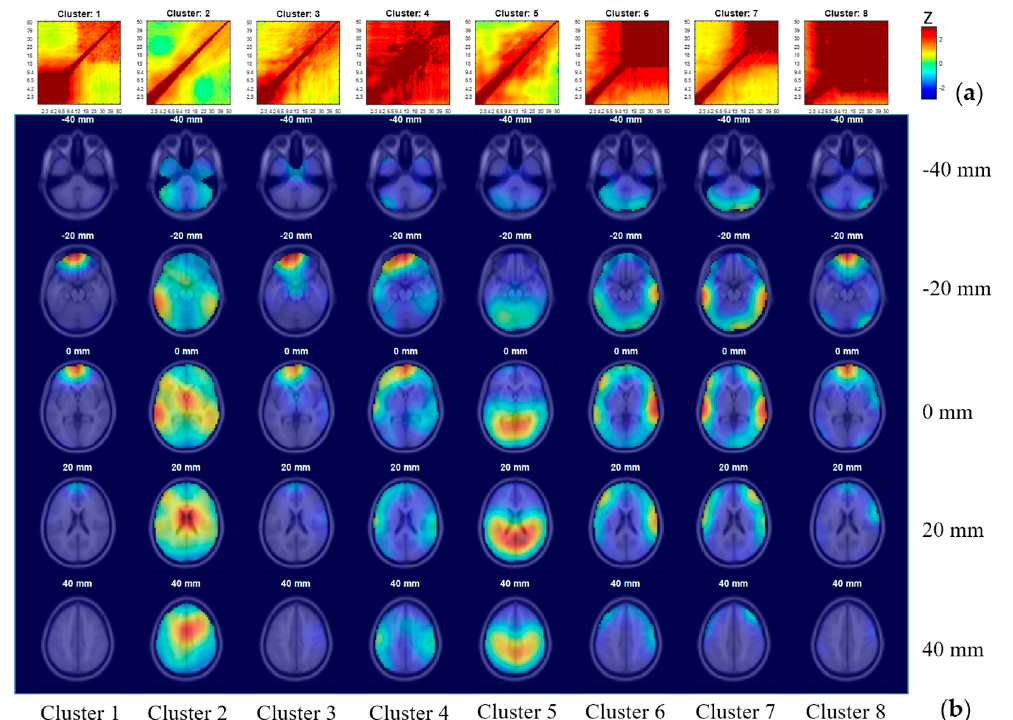
Figure 6. The results from comodulogram-based clustering. ( a ) The correlation matrices standardized in each cluster and represented in the right-panel z scale. ( b ) The dipole density maps projected on anatomical images in axial view at different MNI z coordinates ranging from 0 mm (mm) to 80 mm; warmer color represents a higher density of equivalent dipoles. The same k-means clustering was used with the number of clusters specified to be 8. Cluster 2 and Cluster 5 and potentially Cluster 3 as well were identified as the brain class. Cluster 1 was identified as the eye class. Cluster 6, Cluster 7, and Cluster 8 were identified as the muscle class. Cluster 4 was not classified to any of these categories, thus left as uninterpretable noise.